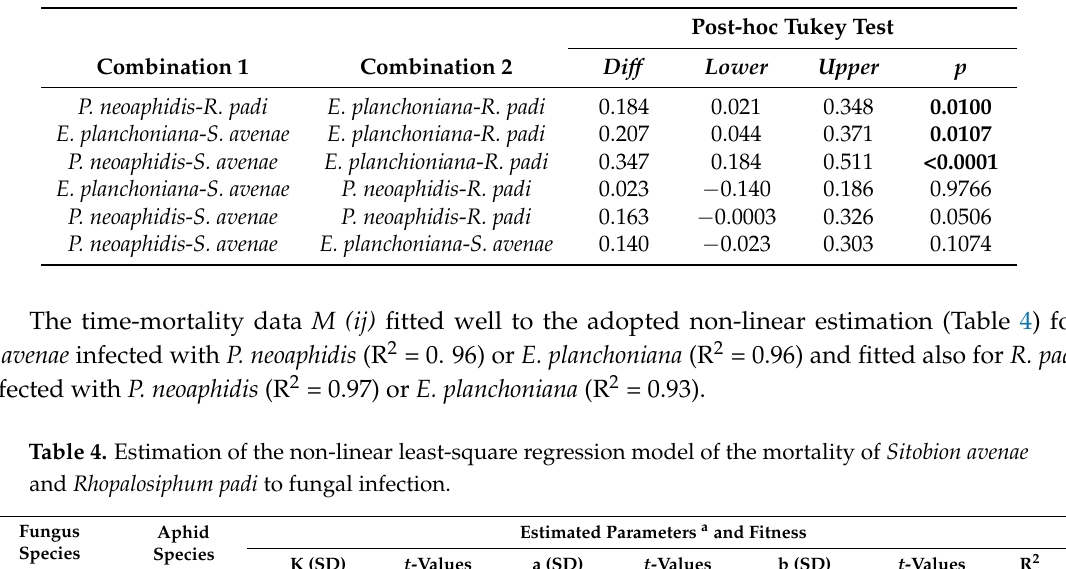
Table 3. Results of Post-hoc Tukey test for multiple comparisons of means with 95% family-wise confidence level. Abbreviations: diff = difference between group means, lower = lower end point of the interval, upper = upper end point of the interval, p = significance level. Values in bold indicate significant differences ( p ≤ 0.05) between the different combinations of the treatment and aphid host species.